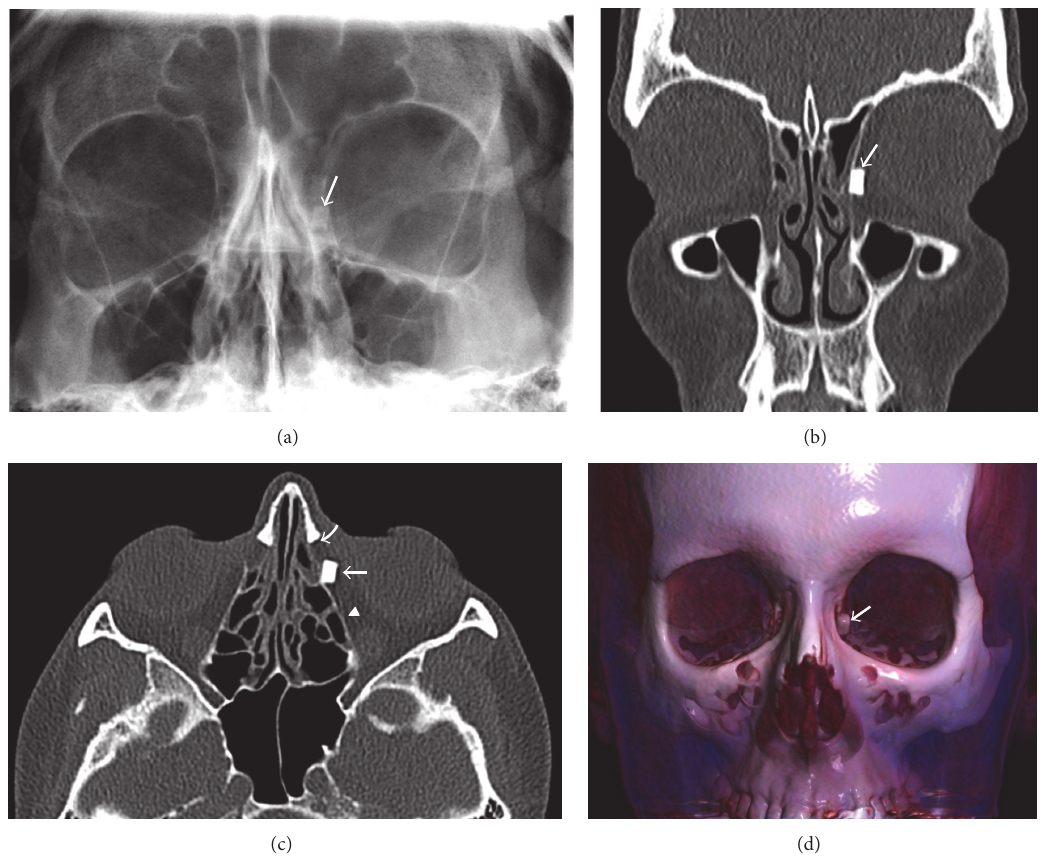
Figure 1: (a–d) Frontal plain radiograph revealing (a) a rectangular high-density body (arrow) overlying the left ethmoid cells and in contact with the lamina papyracea. Contrast unenhanced axial (b) and coronal (c) CT scans show a well-delineated hyperdense body (arrow) within the left orbit, adjacent to the lamina papyracea (arrowhead in (c)) and immediately posterior to the lacrimonasal duct (curved arrow in (c)). (d) 3D-CT volume-rendered reconstructed image shows the intraorbital metallic foreign body